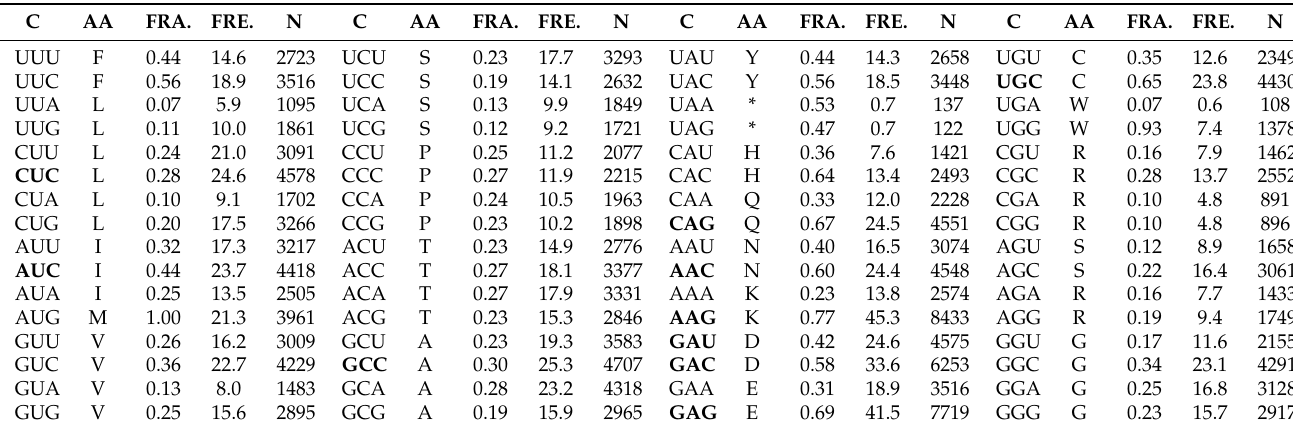
Table 3. The codon usage table of Giardia intestinalis was obtained from the Codon Usage Database via Optimizer